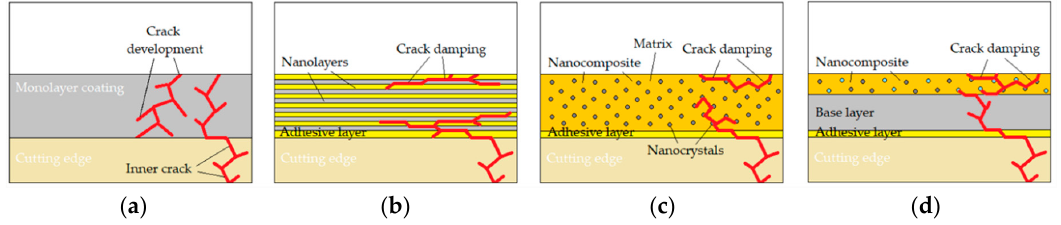
Figure 3. The character of crack development in monolayer and multi ‐ component coatings: ( a ) monolayer coating; ( b ) nanolayered coating with adhesive layer; ( c ) nanocomposite coating with adhesive layer; ( d ) multilayered nanocomposite coating.